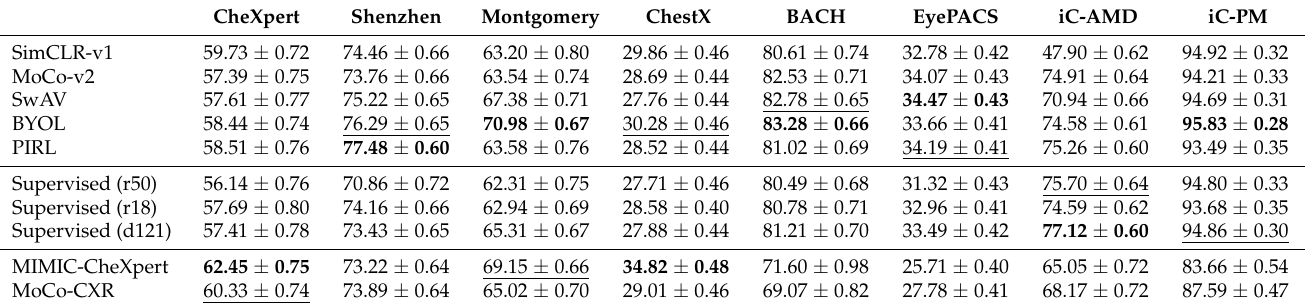
Table 3. Few-shot shot transfer performance of the pretrained models on the different medical datasets. All are evaluated as 2-way 20-shot, except ChestX and EyePACS, which are 5-way 20-shot. Results are reported as average accuracy over 600 episodes with 95% CI. Key: best , second